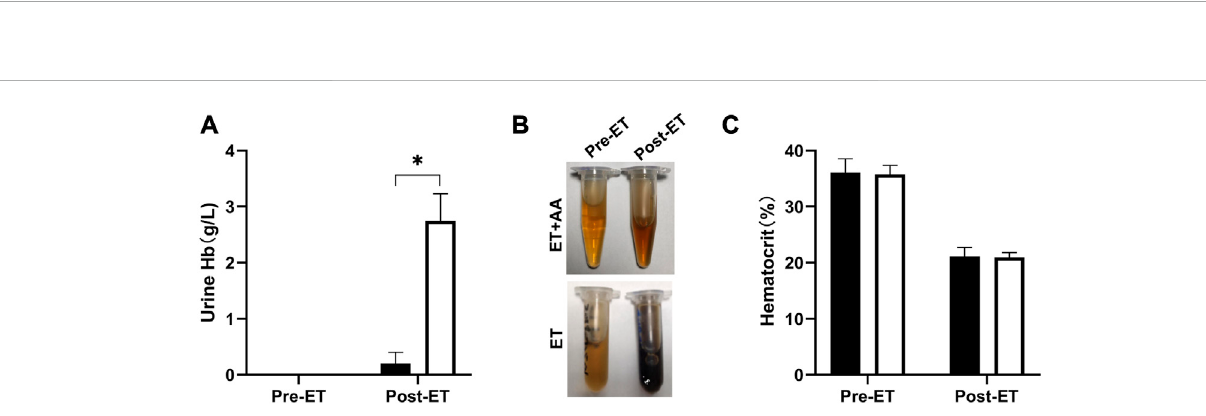
FIGURE 5 Hemoglobinlevels of urine samples and hematocrit pre-ET and post-ET. (A) Urine Hbconcentration of one animal inthe ET+ AA group ( fi lled open bars)andETgroup(openbars). (B) Pictureofurinesamplesinthetwogroups.TheupperpictureisfromoneanimalintheET+AAgroup,thelowerpicture isfromtheETgroup.Ineachpicture,thelefttubecontains urinepre-ET,therighttubecontainsurinepost-ET. (C) Hctdrop afterexchangetransfusionin the ET + AA group. Values are expressed as mean ± SEM, n =